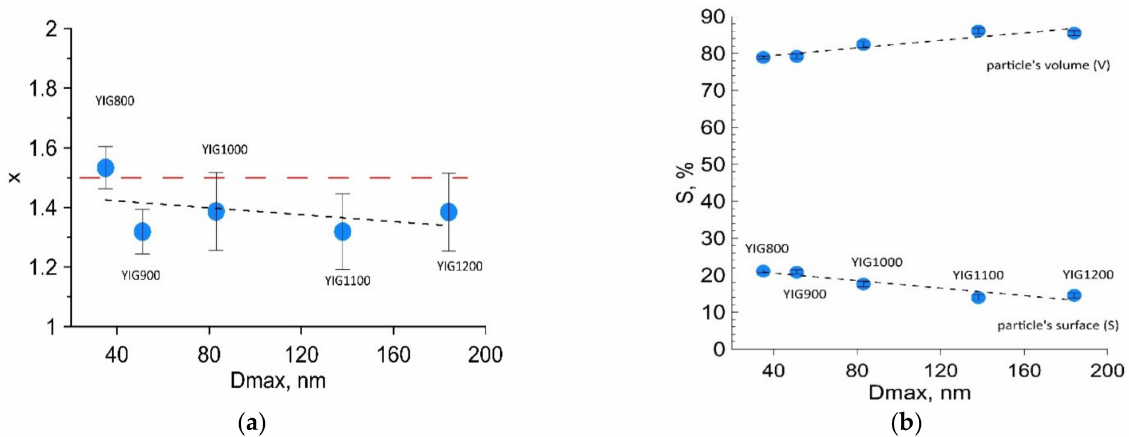
Figure 6. The degree of inversion ( a ) and the amount of surface and bulk fraction of iron in Mössbauer spectrum ( b ) dependences on particle